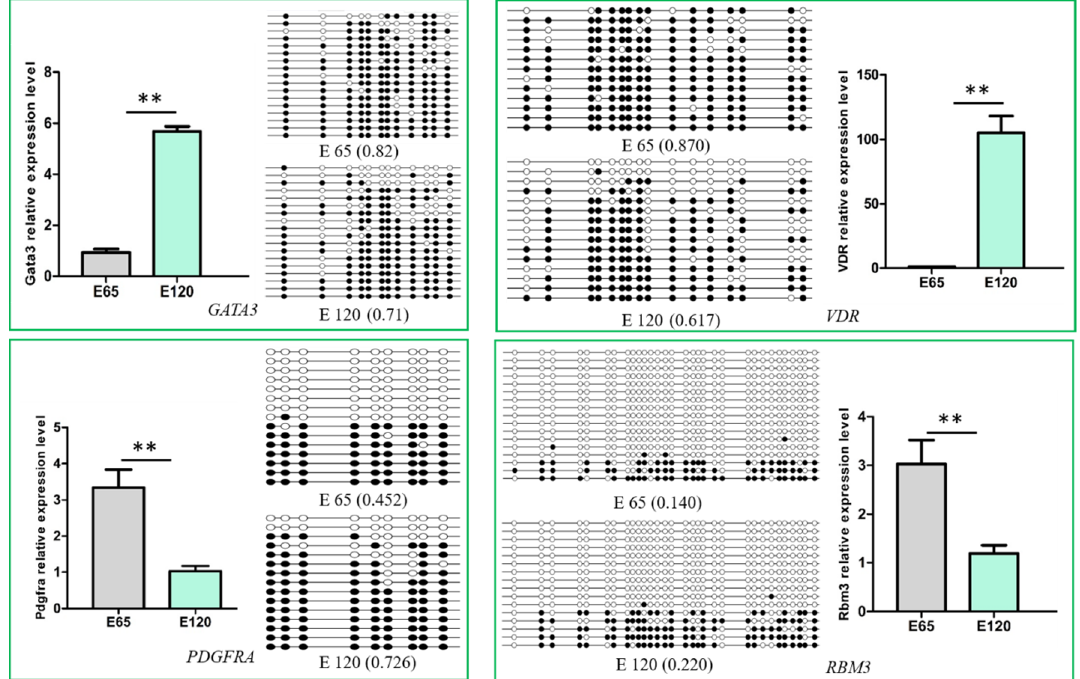
Figure 11. Verification of the differentially methylated genes and their expression. The DNA methylation detected by Bisulfite Sequencing Polymerase Chain Reaction (BSP) was in accordance with the whole-genome bisulfite sequencing (WGBS), and the gene expression was in accordance with the RNA-seq, in which the gene expression was repressed by the high DNA methylation. The expression of specific genes was quantified relative to the expression level of β -actin using the comparative cycle threshold ( ∆∆ CT) method. The data are expressed as the mean ± 1 SE ( n = 3). ** p < 0.01.